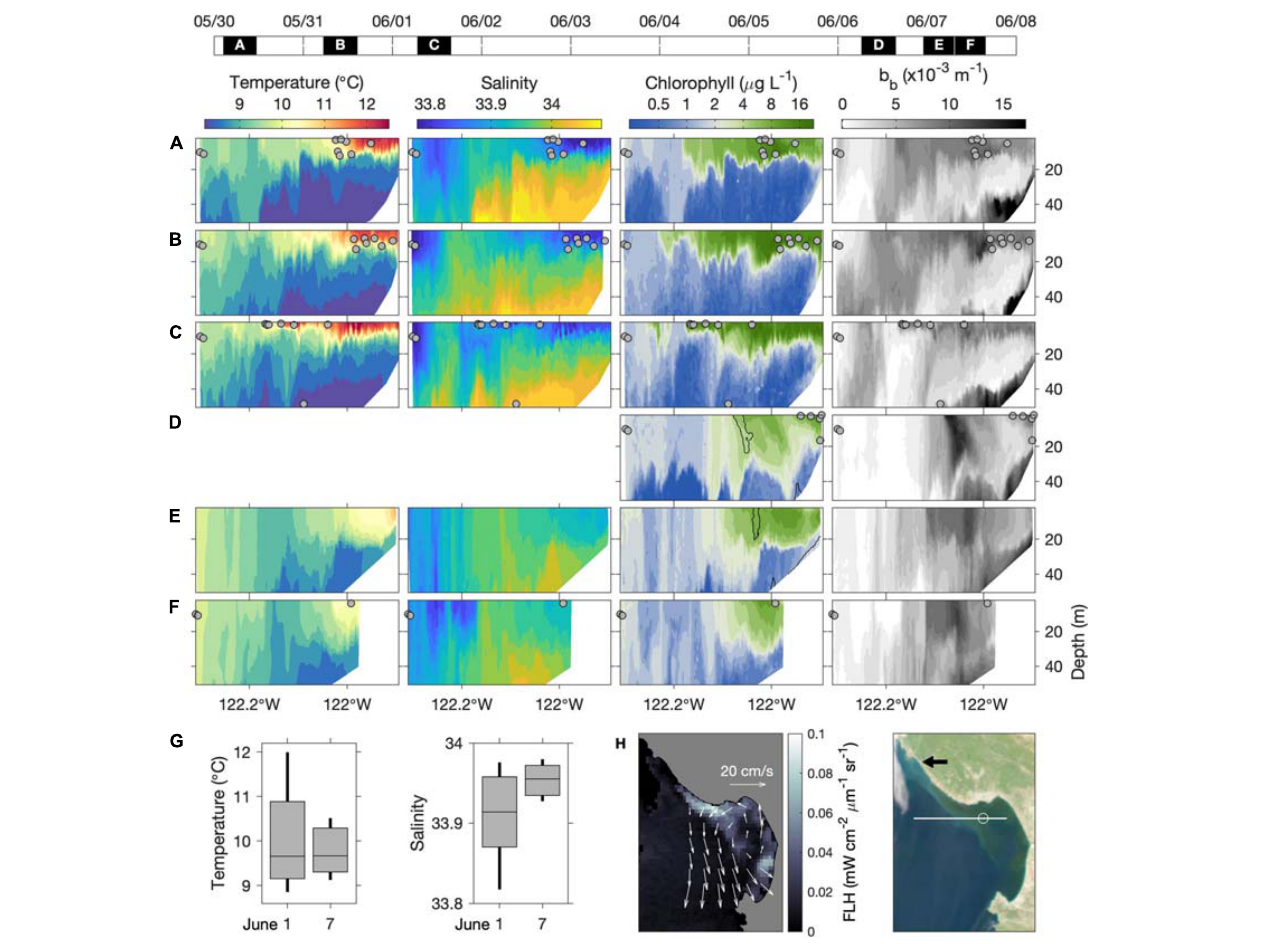
FIGURE 3 | Synoptic in situ and remotely sensed conditions during the process study. (A–F) Vertical sections of temperature, salinity, chlorophyll and optical backscatter along the 36 ◦ 54 (cid:48) N AUV transect ( Figure 2E ). AUV survey dates and pass durations appear on the timeline above (UTC). Blank temperature and salinity sections in (D) resulted from sensor fouling. All sections are from eastbound (water sampling) surveys except (E) , which is shown because nearshore hydrographic data coverage was better than in (F) . Water sample locations are shown in each panel (gray dots). The black contours overlaid in the chlorophyll panels of (D,E) represent maximum optical backscattering (b b ) in the upper water column. (G) Non-parametric boxplots showing percentiles of salinity and temperature measurements from the upper 20 m inshore of 122 ◦ W on June 1 and 7; boxes show the interquartile range, bisected by the mean, and vertical lines span the 10th–90th percentiles. (H) MODIS fluorescence line height (FLH) and RGB “true color” image from 7 June. Overlaid on FLH are surface current vectors from coastal HF radar, representing average velocity over June 1–7. In the true-color image the black arrow indicates the source of the whitish filament that originated in the coastal upwelling center; the white line shows the AUV transect; the white circle is a reference point at 122 ◦